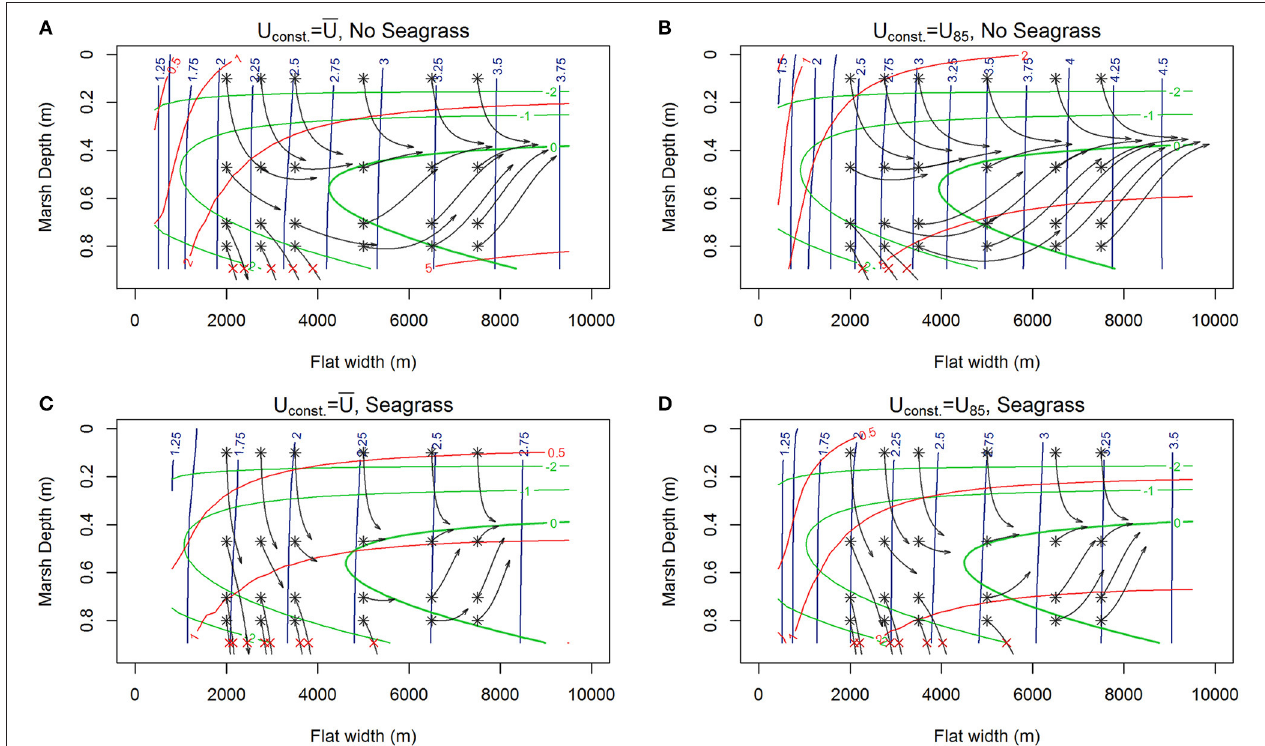
FIGURE 3 | Contours of lateral rates of change in tidal flat width (m /year, red), and vertical changes in marsh depth (mm/year, green) alongside 1000-year trajectories (black) of the system initiated at various tidal flat widths and marsh depths along the tidal flat depth nullcline surface (blue contours) for various winds (RSLR = 4mm year − 1 , Co = 10 mg/L). (A) Constant wind ( U const = U = 6.87m s − 1 ), no seagrass, red contours indicating erosions, and marsh drowning of low-lying marshes with fetches up to 4km exhibited by trajectories ending with red x. (B) Constant but higher wind ( U const = U 85 = 8.5m s − 1 ), no seagrass, showing faster erosion, deeper flat, and only very low-lying marshes drowning for fetches < 3.5km. (C) Constant wind and seagrass ( U const = U = 6.87m s − 1 , N = 250 shoots m − 2 ) showing reduced erosion of the salt marsh and a shallower system with ‘enhanced’ drowning of low-lying marshes up to fetches of 5km. (D) Constant higher wind with seagrass ( U const = U 85 = 8.5m s − 1 , N = 250 shoots m − ) showing erosion and drowning of low-lying marshes up to fetches of